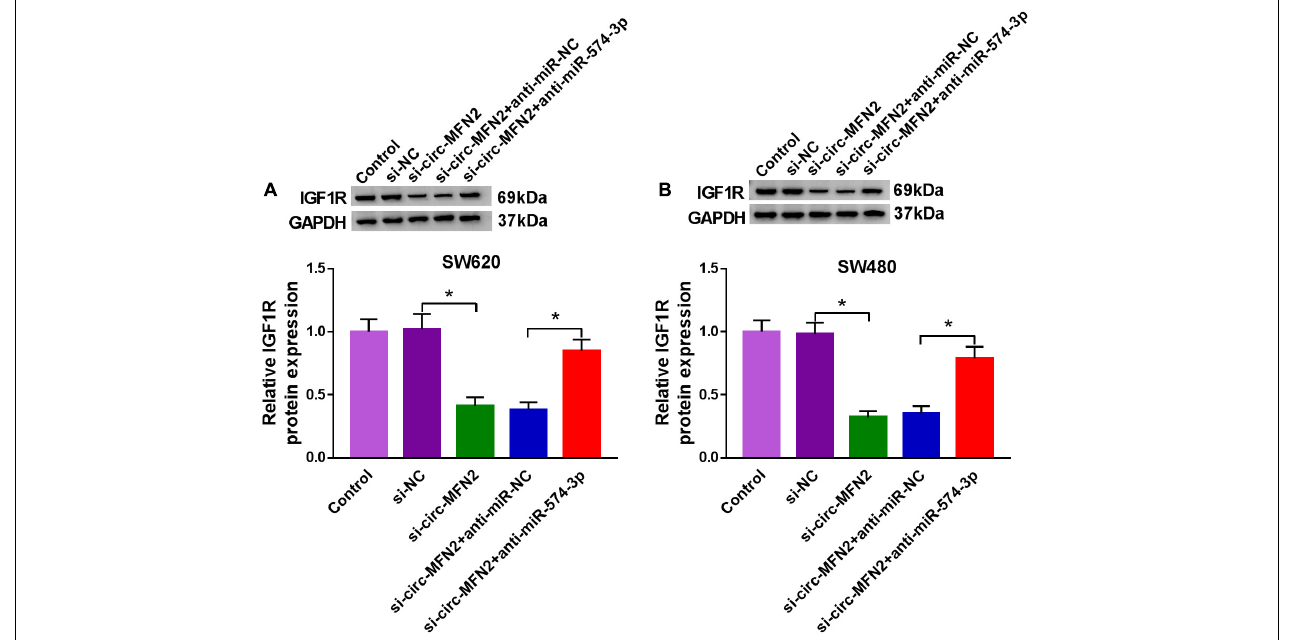
FIGURE 8 | Circ-MFN2 and miR-574-3p regulated IGF1R expression. SW620 and SW480 cells were transfected with si-NC, si-circ-MFN2, si-circ-MFN2 + anti-miR-NC or si-circ-MFN2 + anti-miR-574-3p, and non-transfected cells were used as control. The protein level of IGF1R in SW620 (A) and SW480 (B) cells was measured using WB analysis. * P <